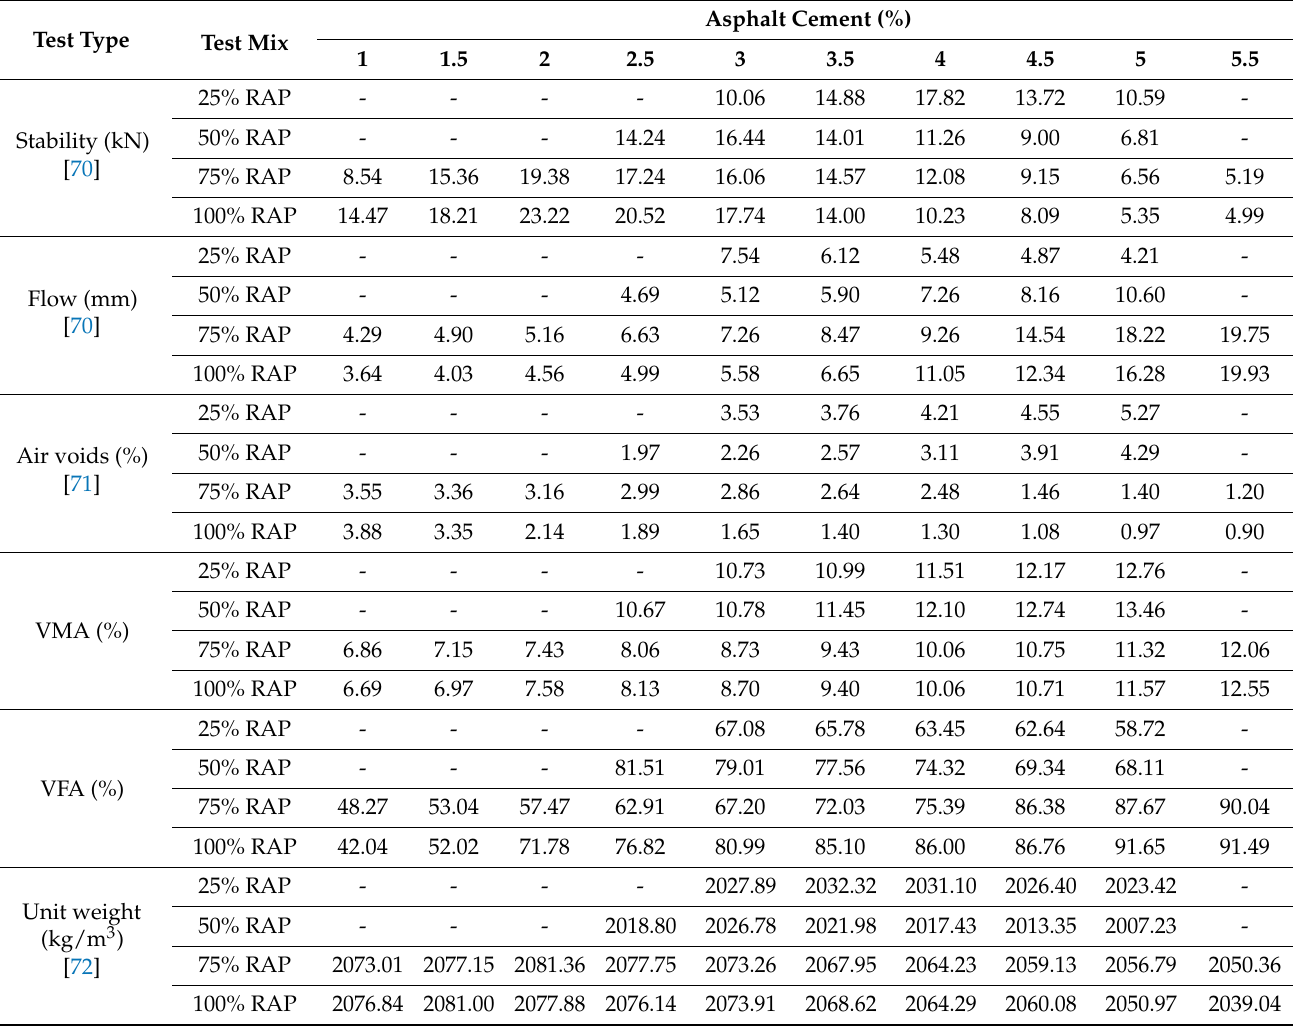
Table 4. Test results for the tested mix prepared with RAP